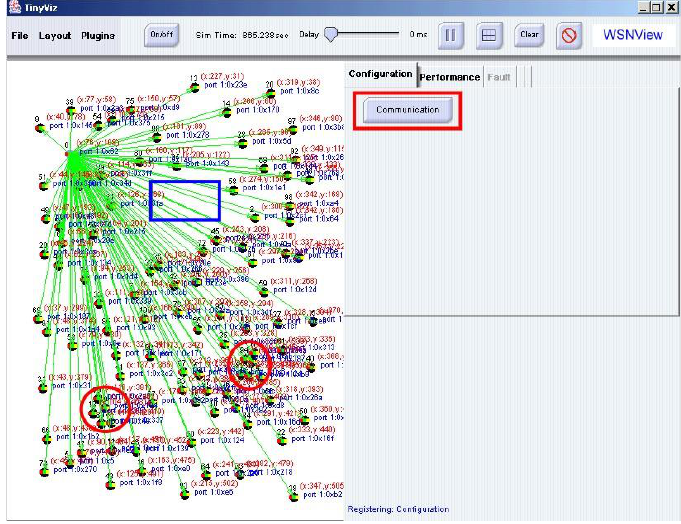
Figure 5. Configuration of Sensor Deployment.